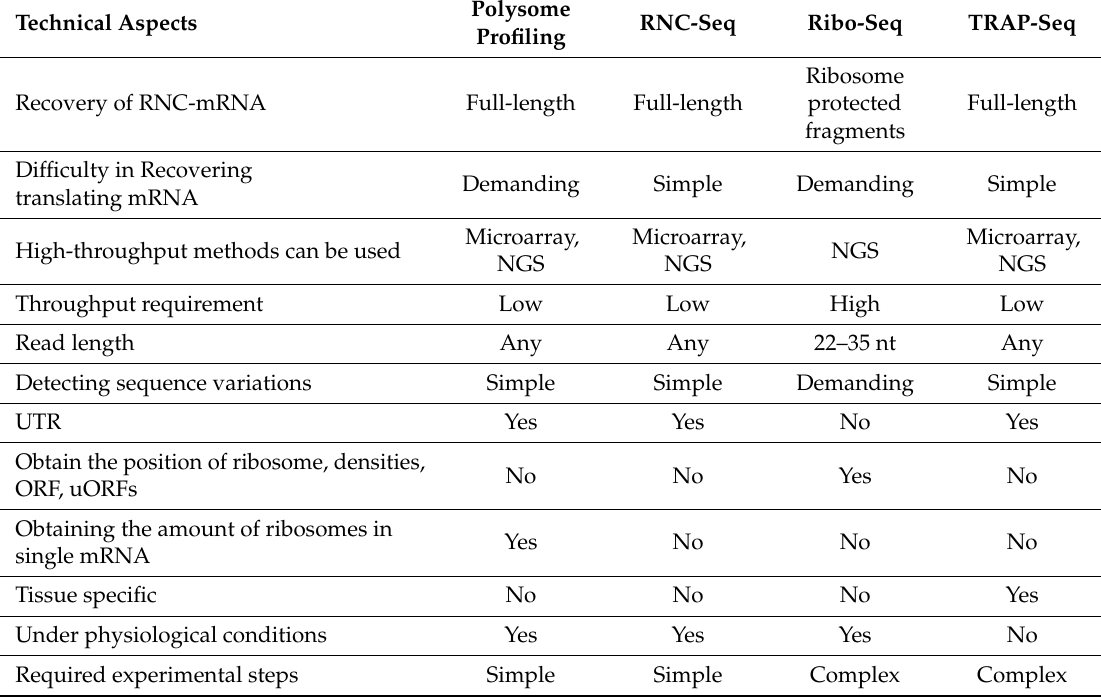
Table 1. Technical comparison of translatomic